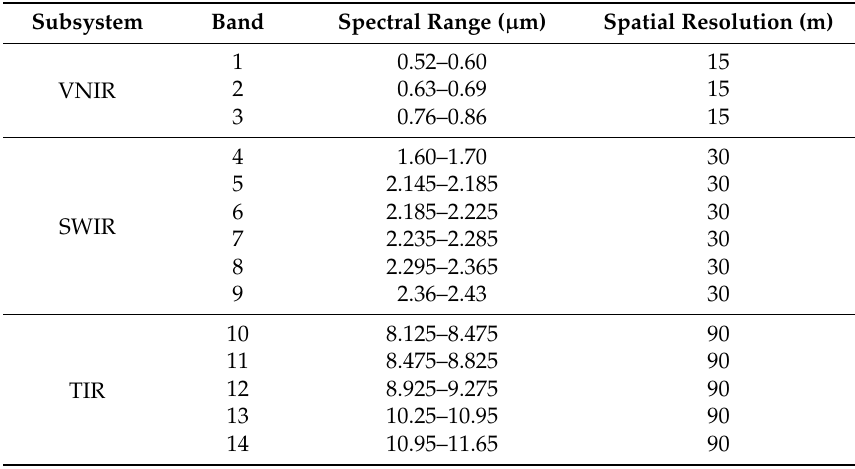
Table 1. ASTER bandpass and spatial